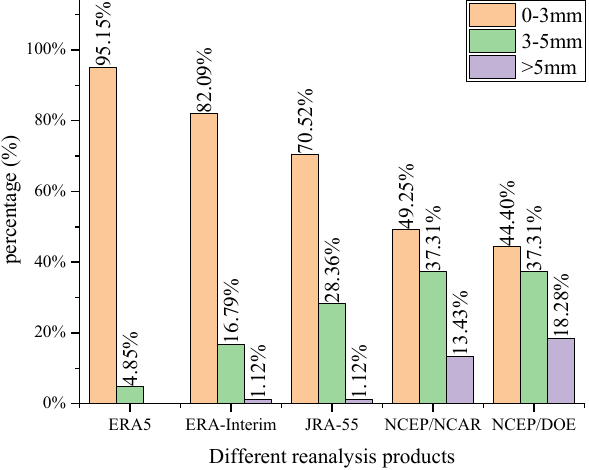
Figure 5. Percentages of RMSE values for ERA5, ERA ‐ Interim, JRA ‐ 55, NCEP/NCAR, and NCEP/DOE reanalysis water vapor products relative to GNSS PWV around the world (source: own elaboration).